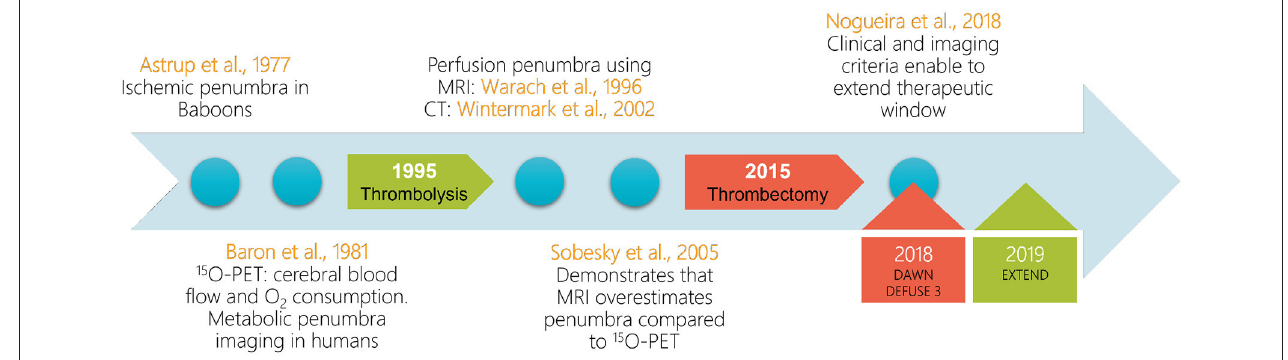
FIGURE 4 | Summarized development timeline of the penumbra imaging field. Circles: the major contributions to the acute ischemic stroke research field. Arrows: the clinical validation years for reperfusion therapies. Rectangles: the major clinical trials using advanced imaging to extend therapeutic windows. Red and green code for